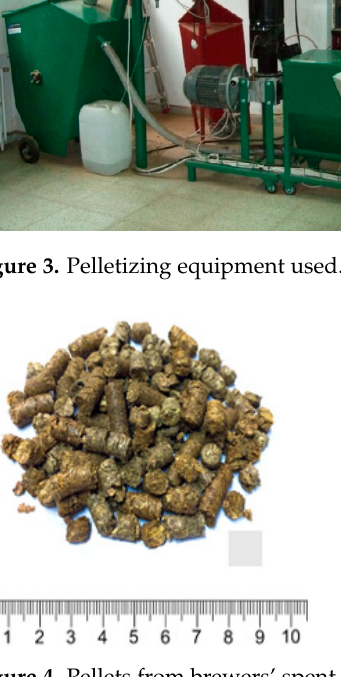
Figure 4. Pellets from brewers’ spent grain.